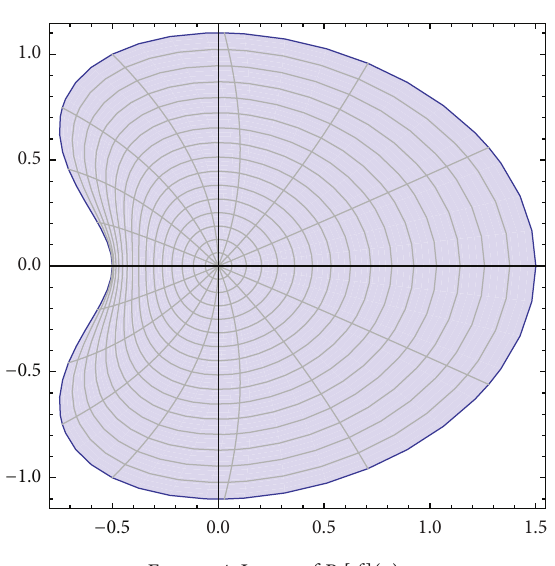
Figure 4: Image of 𝑃 1 [𝑓](𝑧)